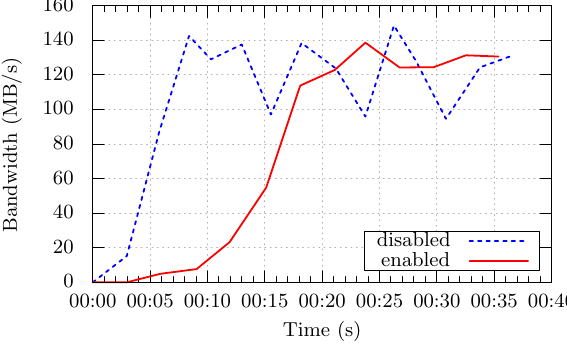
Figure 8: Bandwidth during start of TCP data transfer with/without